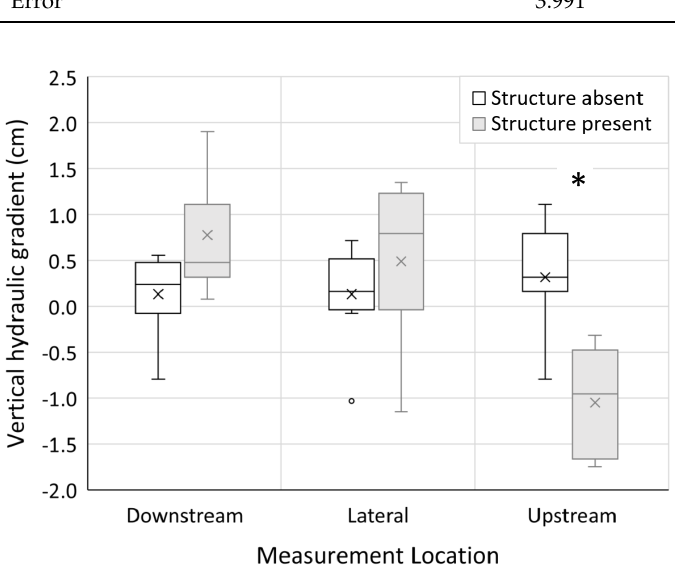
Figure 4. Box and whisker plots of directional vertical hydraulic gradient at measurement locations (downstream, lateral, and upstream) where in-channel structure was present (grey plots) versus absent (open plots). The box represents the data range between 1st and 3rd quartile, the horizontal line in the box represents the median, the x in the box represents the mean, and the whiskers represent the minimum and maximum values excluding the outliers (small circles). Asterisks (*) indicate a significant difference between measurement locations containing in-channel structure and lacking in-channel structure.